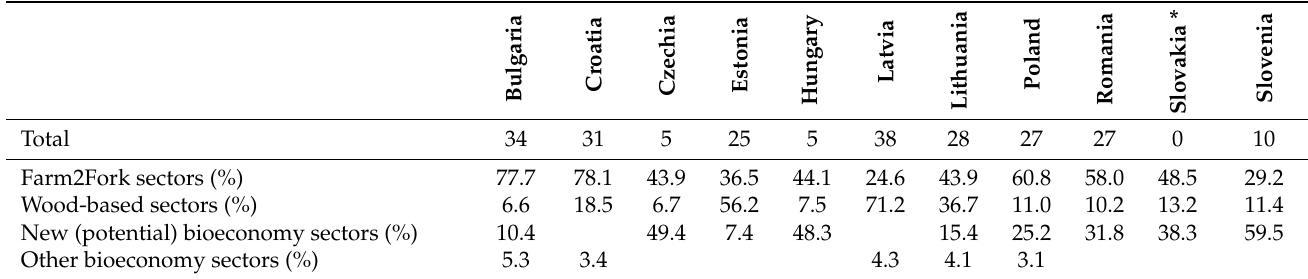
Table 2. Share of (potentially) bio-based products among PRODCOM products that generate 50% of total